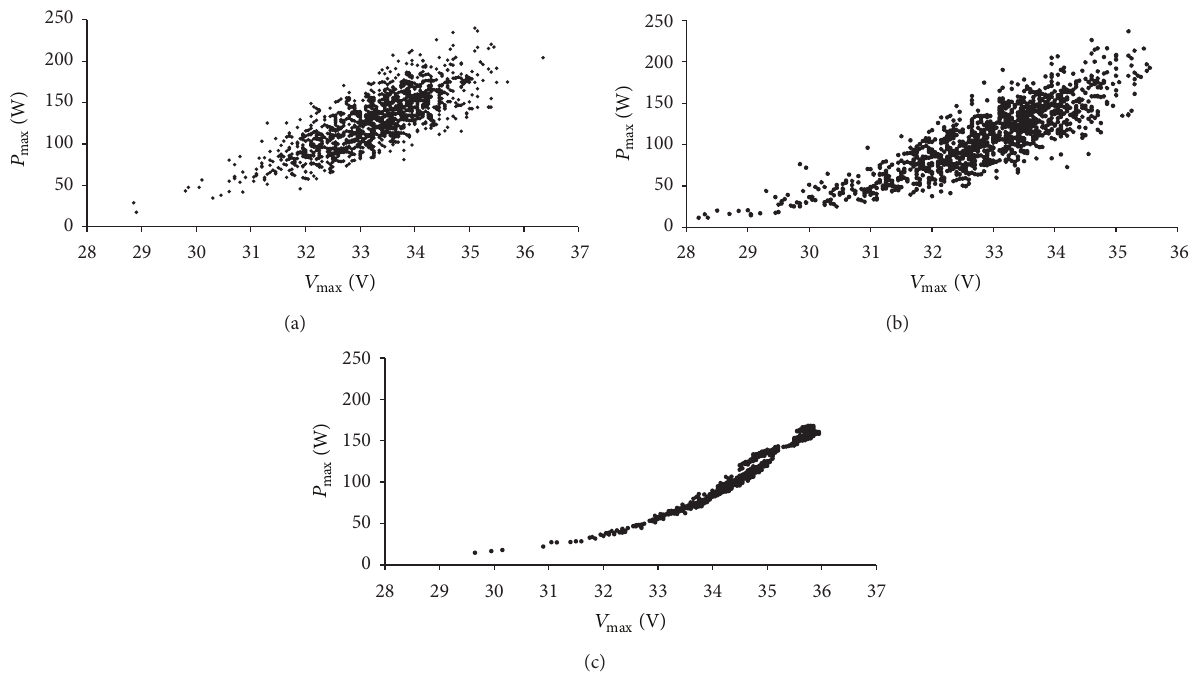
Figure 6: MPP distribution under simulated environment: (a) Gaussian distribution function generated environment data, (b) the set in (a) added with sun occultation by clouds, and (c) MPP distribution obtained using real weather